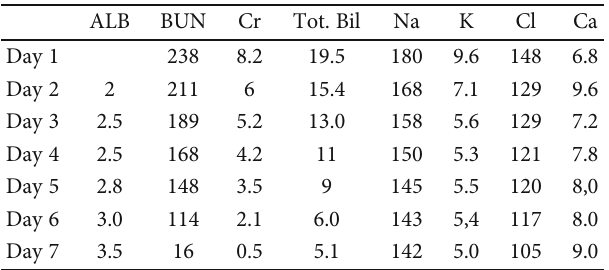
Table 2: Subsequent laboratory investigations on a daily basis disclosed the following values